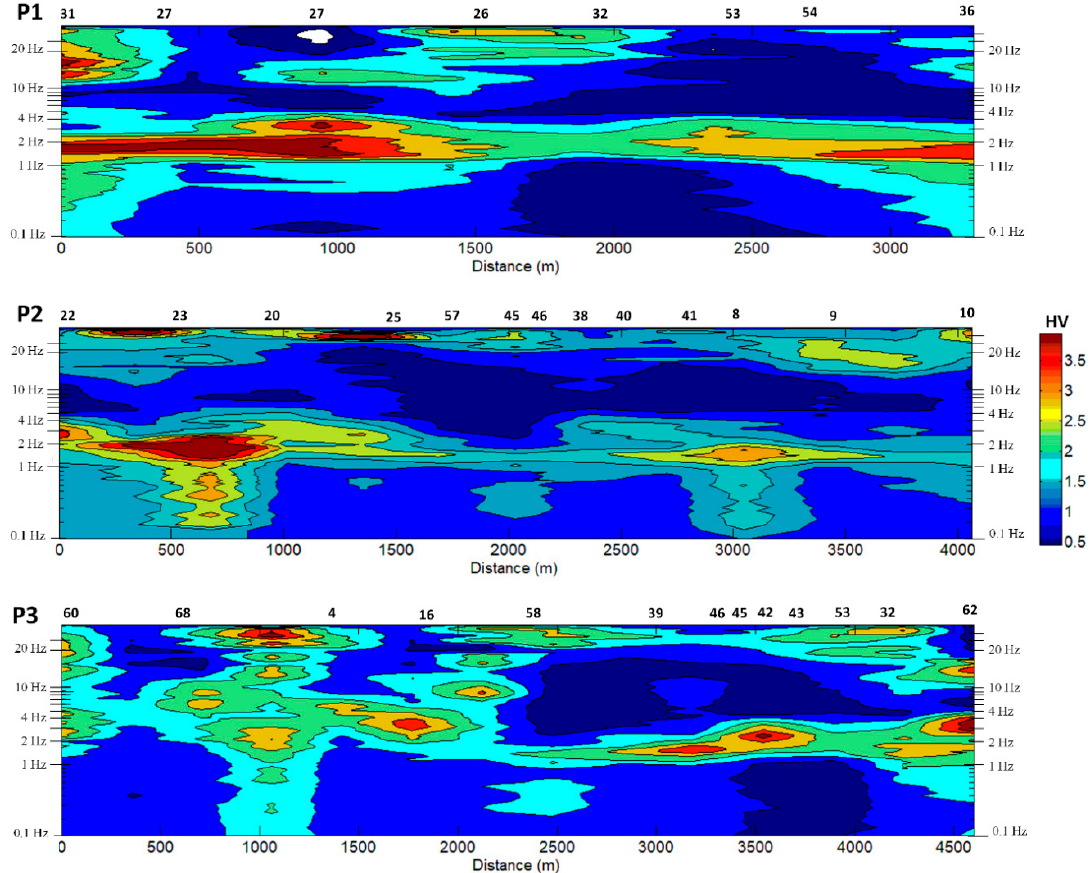
Figure 10. Extrapolated HVSR amplitude-frequency contours vs. distance profiles (marked with yellow dashed lines in Figures 6 and 9). Microtremor measurement locations are marked above figure.